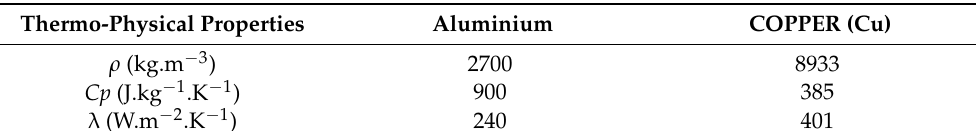
Figure 4. Effect of inlet nanoparticles volume fraction on the cumulated condensation rate: T 0L =293.15 K,